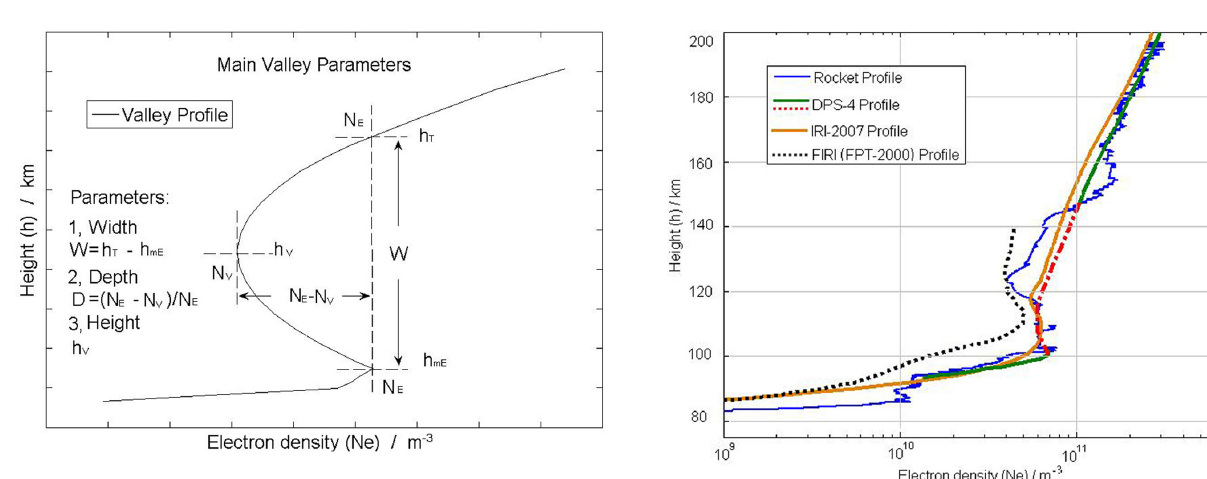
Fig. 1. An E–F valley profile with parameters from Gulyaeva (1987), Mahajan et al. (1994) and Titheridge (2003). Fig. 2. The sounding rocket electron density profile (blue line) and the DSP-4 simultaneous electron density profile (green full line rep- resents data; the red dashed line is an interpolation) obtained at Hainan station, along with the IRI-2007 (brown full line) and FIRI (FPT-2000 option of IRI) profiles (gray dashed